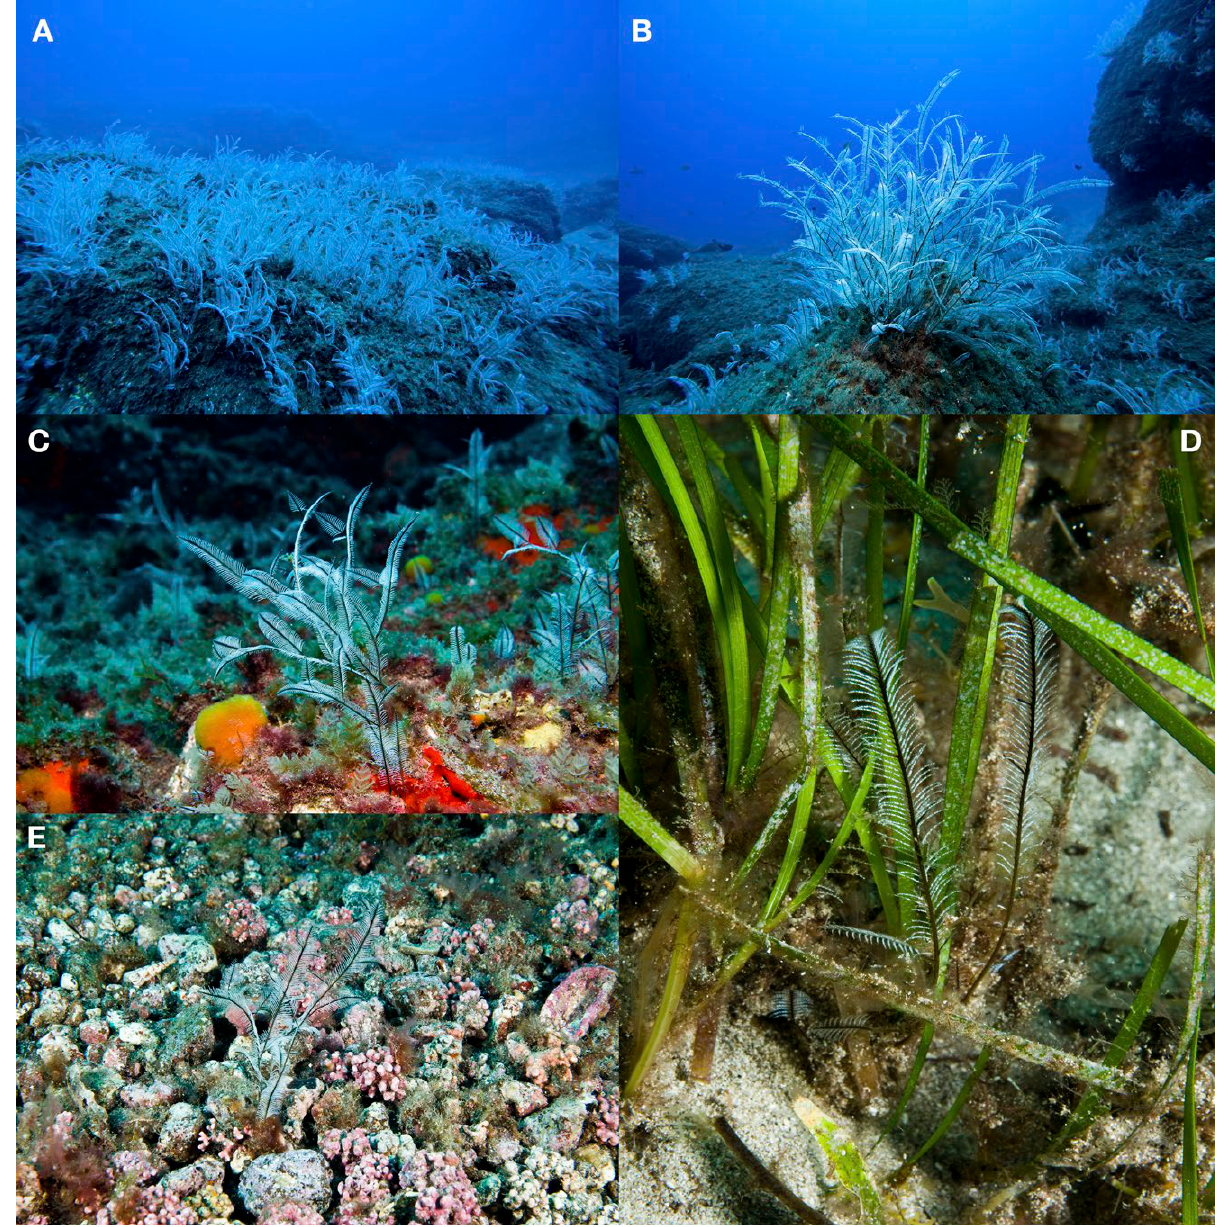
Fig. 1. – Colonies of M. philippina on different types of habitats, including (A and B) rocky reefs, (C) a rocky bottom with Aplidium proliferum (Chordata) and Crisularia gracilis (Bryozoa), (D) the edge of a seagrass meadow and (E) rhodolith